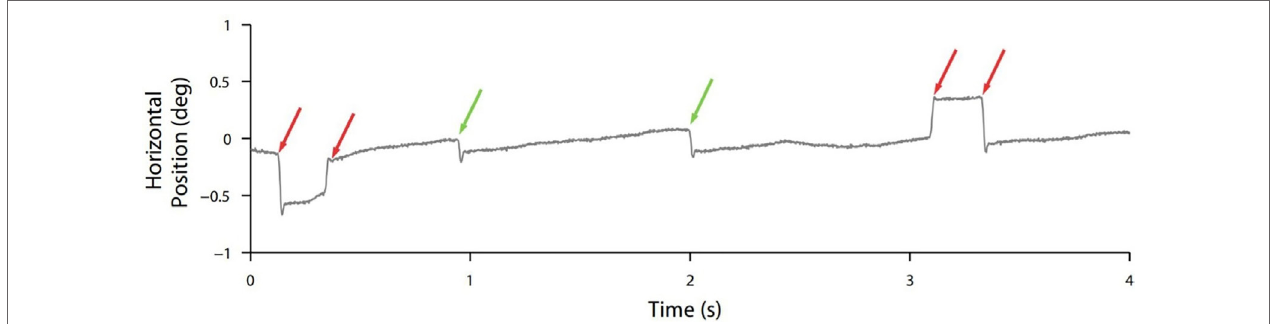
FigURe 2 | Square-wave coupling takes place for large but not small (micro)saccades. In this eye position trace from a healthy participant, red arrows point to pairs of larger microsaccades forming square-wave jerks; green arrows point to smaller unpaired microsaccades. From Otero-Millan et al.